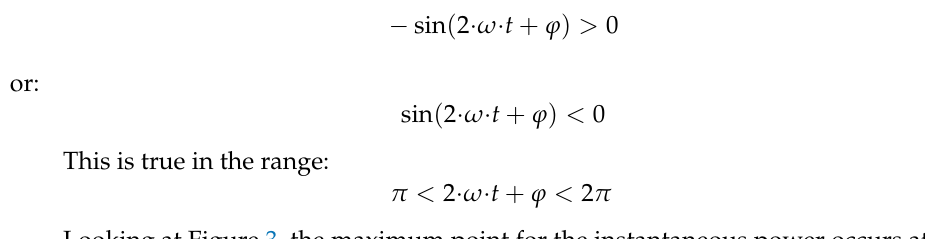
Figure 3. Trend of instantaneous power and its time derivative in Equations (9) and (11). The time derivative of the instantaneous power in (11) is positive